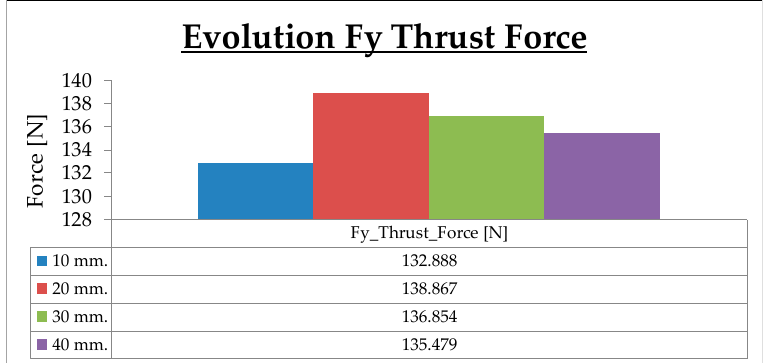
Figure 23. Thrust forces versus an increment of the transversal slots.